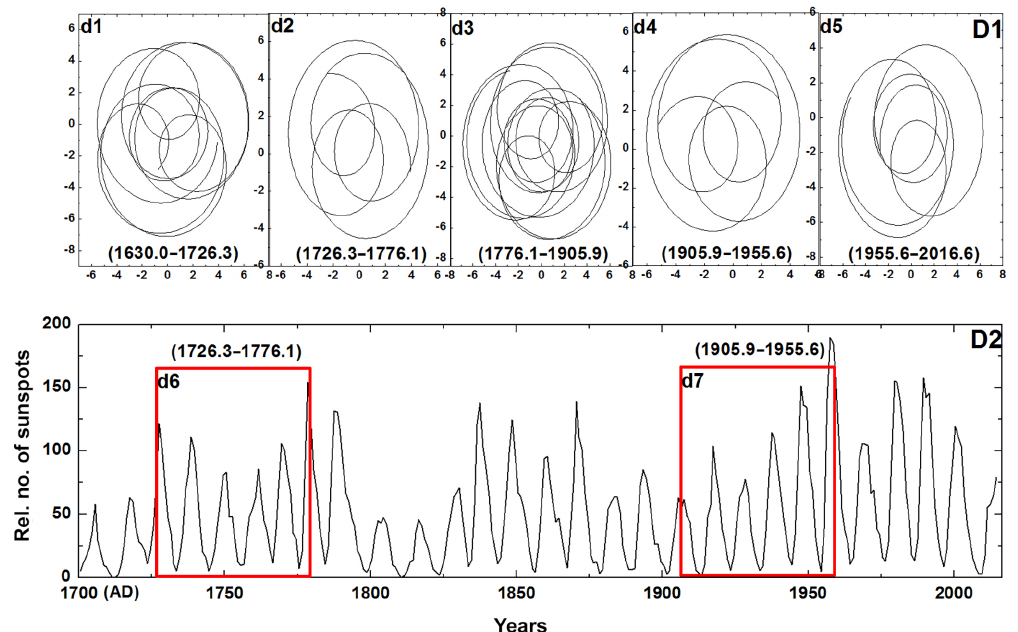
Figure 6. Contrast of the trajectory of the planetary system and solar